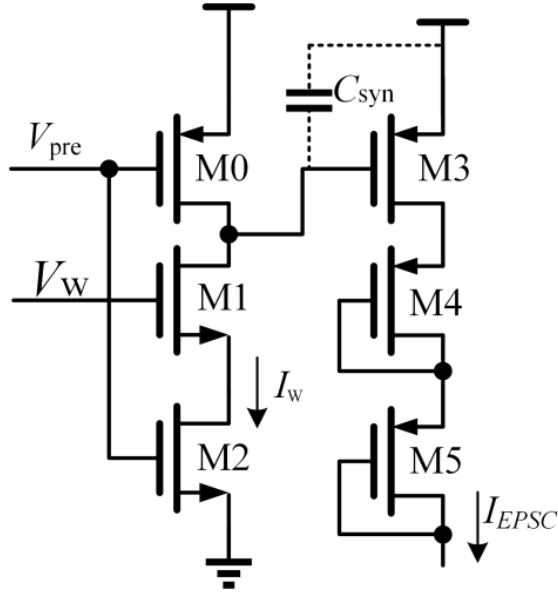
Figure 2. Excitatory synapse.